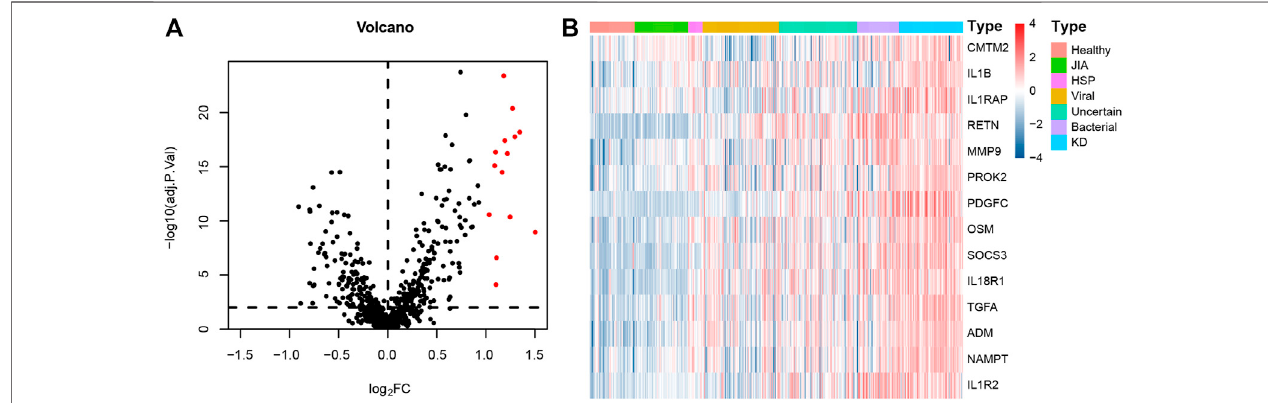
FIGURE 1 | Immune-related DEGs expression volcano plot and heatmap between KD and non-KD. (A) Volcano plot of immune-related DEGs; red represents upregulateddifferentialgenes,andblackrepresentsnosigni fi cantdifferencegenes(|log2FC| > 1andadjusted p < 0.01). (B) Heatmapofimmune-relatedDEGsinKDand non-KD. From blue to red represents the change from low expression to high expression (all immune-related